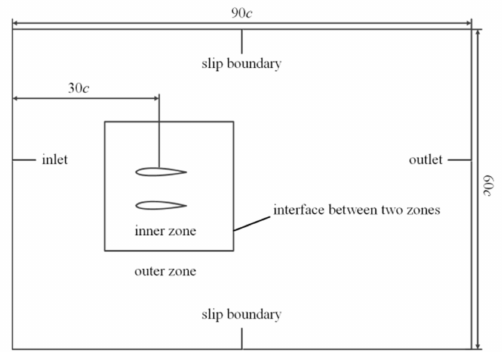
Figure 2. The computation domains arrangement.